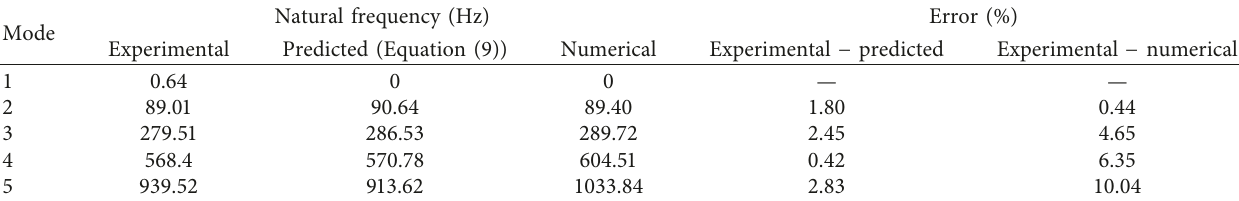
Table 3: Natural frequencies of the pinned-free beam with respect to the strong axis ( X ). Mode